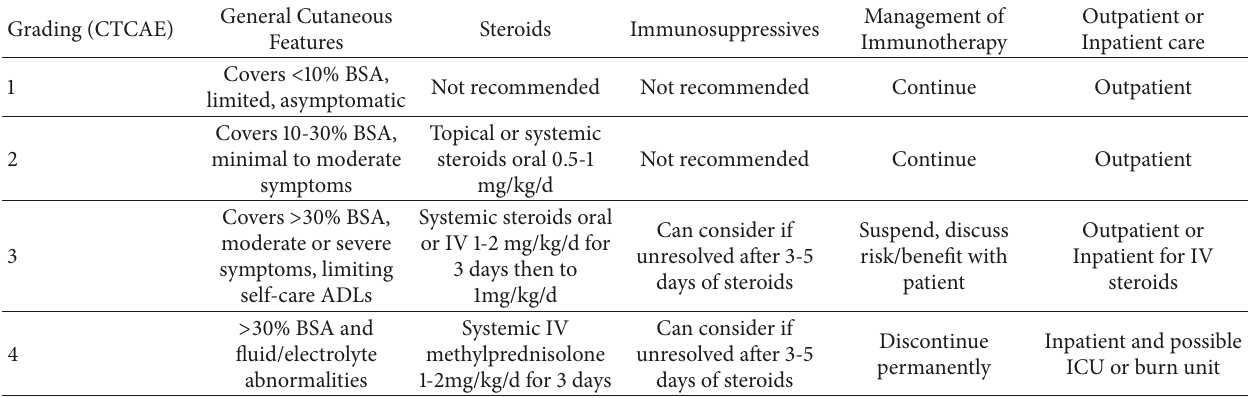
Table 1: Skin and subcutaneous tissue disorders management of different gradings based on CTCAE (Common Terminology Criteria for Adverse Events)